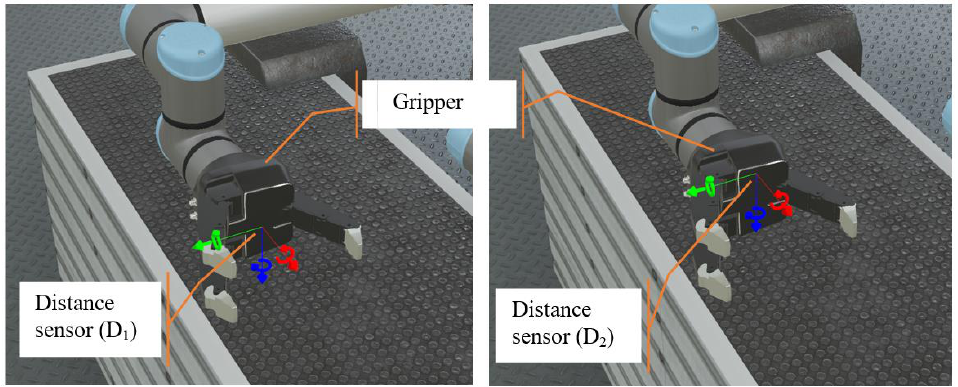
Figure 3. The tips of the robot arms.